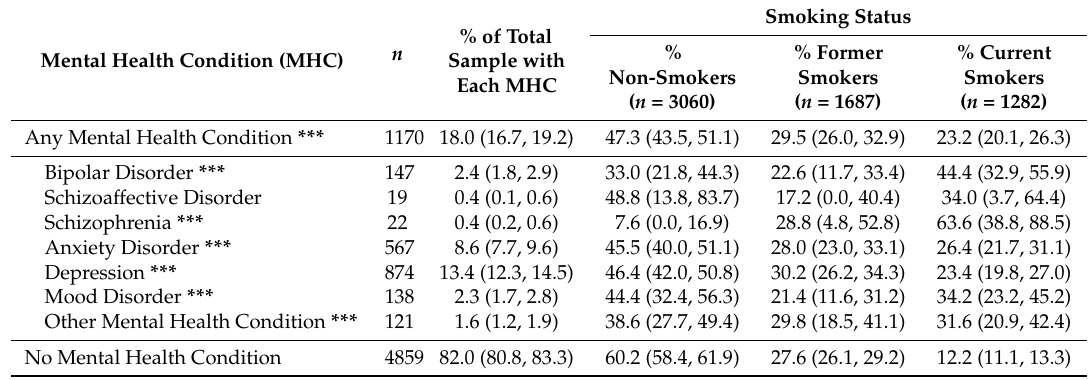
Table 2. Smoking status percentages by lifetime mental health